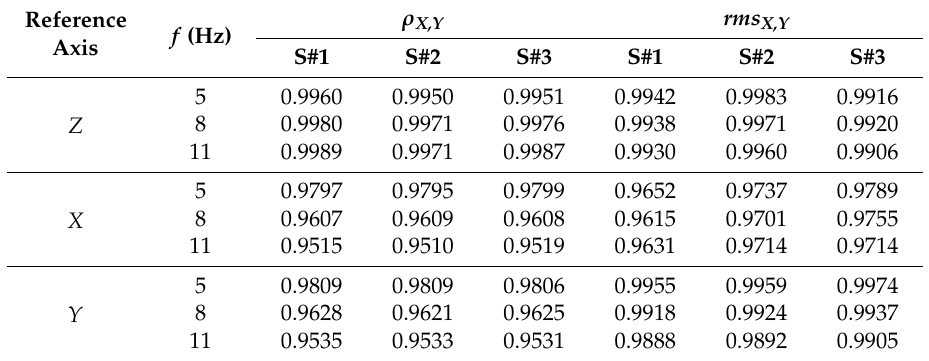
Table 2. Statistical coefficients derived from laboratory test measurements (Equations (3) and